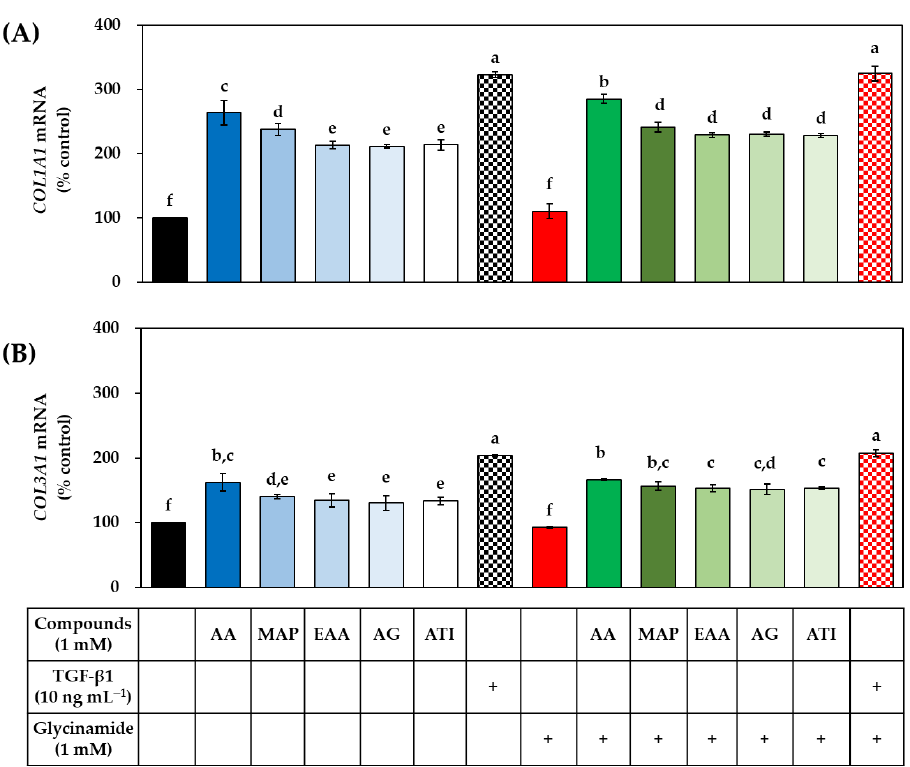
Figure 10. Effects of individual and combined treatments of AA analogs (such as AA, MAP, EAA, AG, and ATI), glycinamide, and TGF- β 1 on the mRNA expression of procollagen genes in HDFs. Cells were treated with an AA analog or TGF- β 1 in the absence or presence of glycinamide for 12 h. The mRNA levels of COL1A1 ( A ) and COL3A1 ( B ) were analyzed by qRT-PCR and the results were normalized to that of GAPDH . Data are presented as % of control (means ± SD, n = 3). Groups that share the same alphabet letters (a – f) do not have significantly different means at the p < 0.05 level.